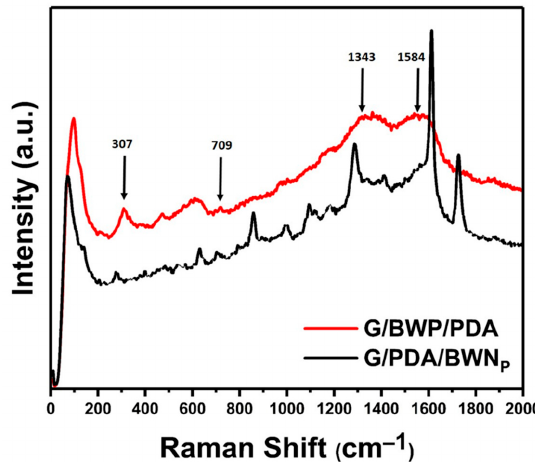
Figure 5. Raman spectra of G/BWP/PDA and G/PDA/BWN P